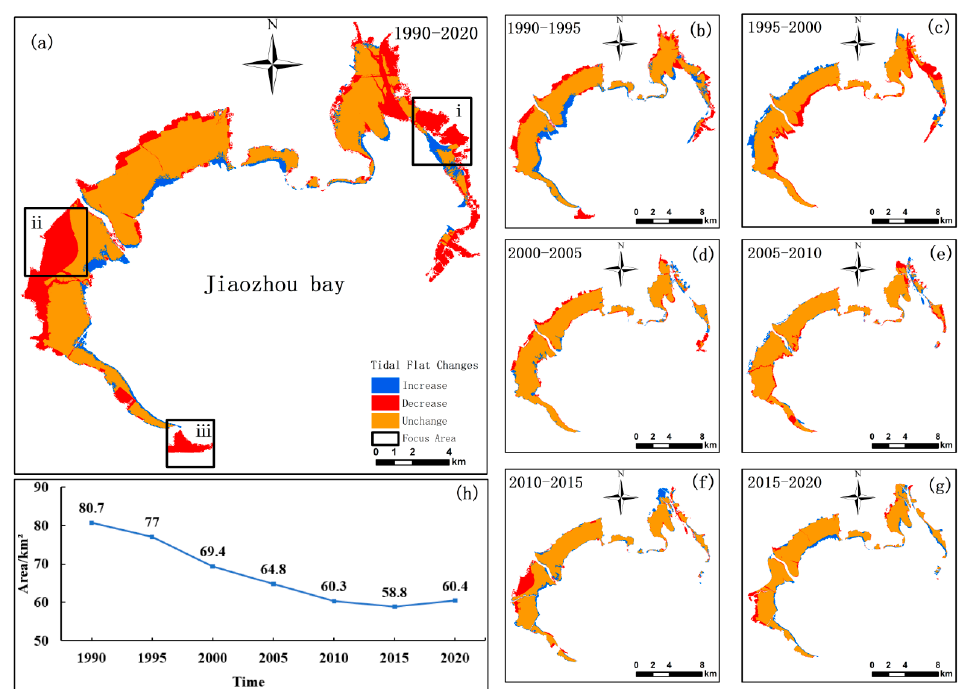
Figure 10. Changes in the tidal flats in Jiaozhou Bay from 1990 to 2020. ( a ) Overall changes; ( b ) 1990–1995; ( c ) 1995–2000; ( d ) 2000–2005; ( e ) 2005–2010; ( f ) 2010–2015; ( g ) 2015–2020; ( h ) change in tidal flat area.